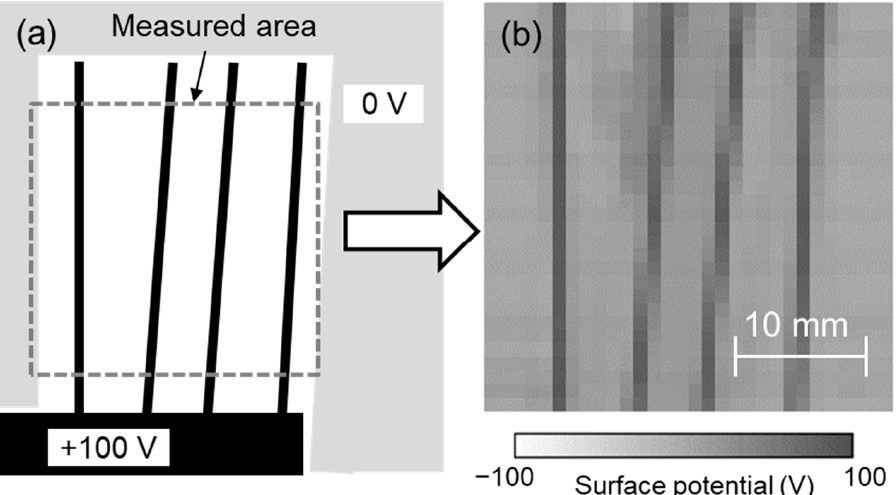
Figure 8. ( a ) Test sample 3 and ( b ) surface potential distribution measured using developed system.